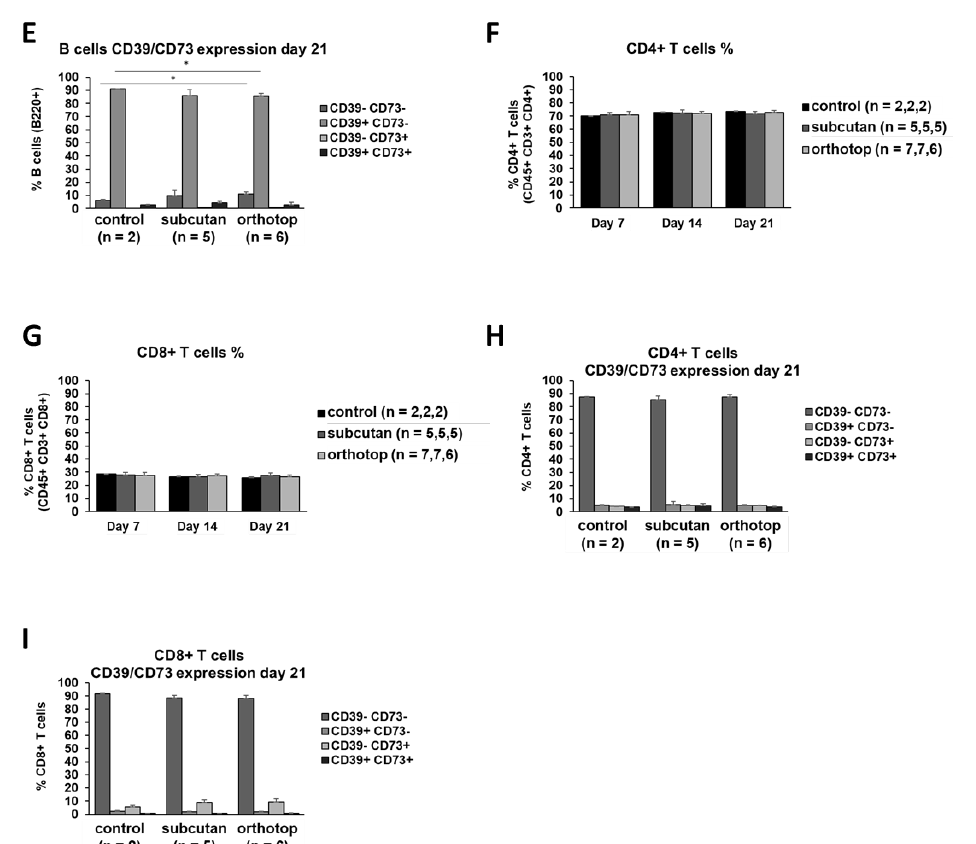
Figure 7. Cell populations in inguinal lymph nodes of orthotopic and subcutaneous HNSCC-bearing mice. ( A – E ) Popula- tions of B cells and subgroups of B cells were analyzed using flow cytometry. ( D , E ) The expression profile for IgM/IgD and CD39/CD73 was determined in B cells. ( F , G ) Populations of CD4 + and CD8 + T cells were analyzed using flow cytometry. ( H , I ) The expression profile for CD39/CD73 was determined on T cells. Percentages were calculated based on relative lymphocyte numbers. Values are shown for day 0 (control), day 7, day 14, and day 21. On day 7, day 14, and day 21, the test group size for the subcutaneous group is n = 5, while for the control group n = 2. The test group size for the orthotopic group on day 7 is n = 7, day 14 n = 7, and day 21 n = 6. p -values < 0.05 were considered to be significant with (*). Data shown here are listed in Table S4.